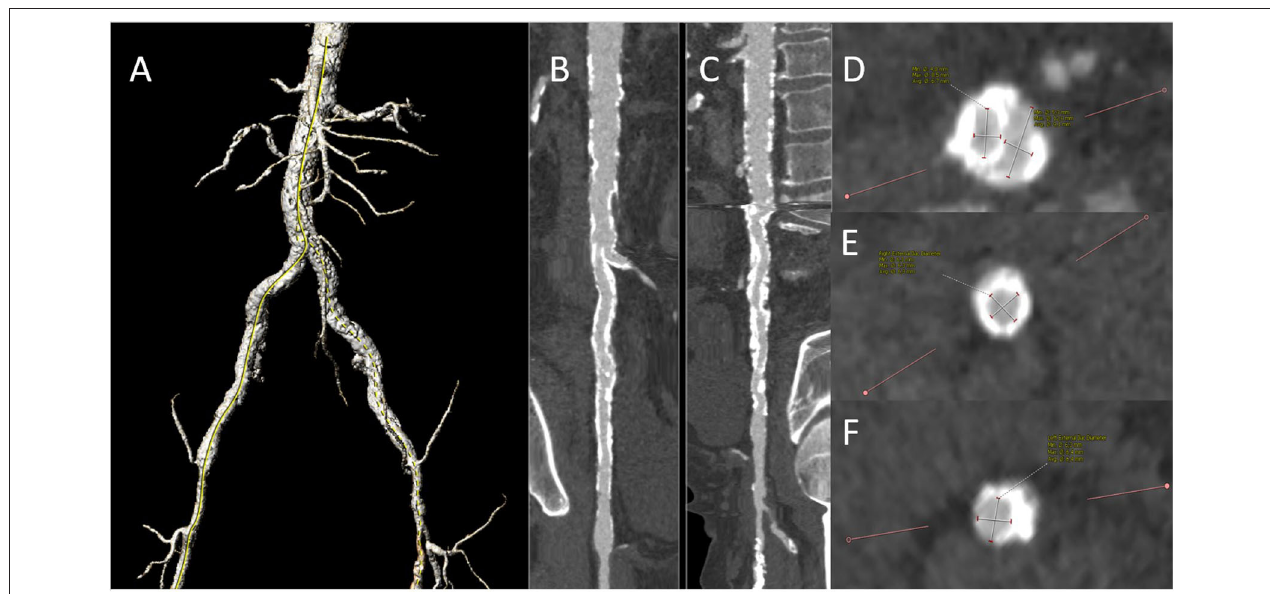
FIGURE 6 | Preinterventional CT angiography demonstrating severe aorto-iliac PAD: 3-D reconstruction of pelvic vessels (A) . A stretched vessel analysis of the right (B) and left (C) axis and infrarenal aorta demonstrating severe calcification. Slice of the iliac bifurcation (D) , the right external iliac artery (E) , and the left external iliac artery (F) Both the iliacs were already provided with the self-expandable stents in the past. Duplex ultrasound displayed hemodynamically severe iliac stenoses with a peak systolic velocity of 2.6 m/s in the right common iliac and 3.0 m/s in the left external iliac artery. We decided to perform a staged procedure with the preparation of the iliac vessels first.